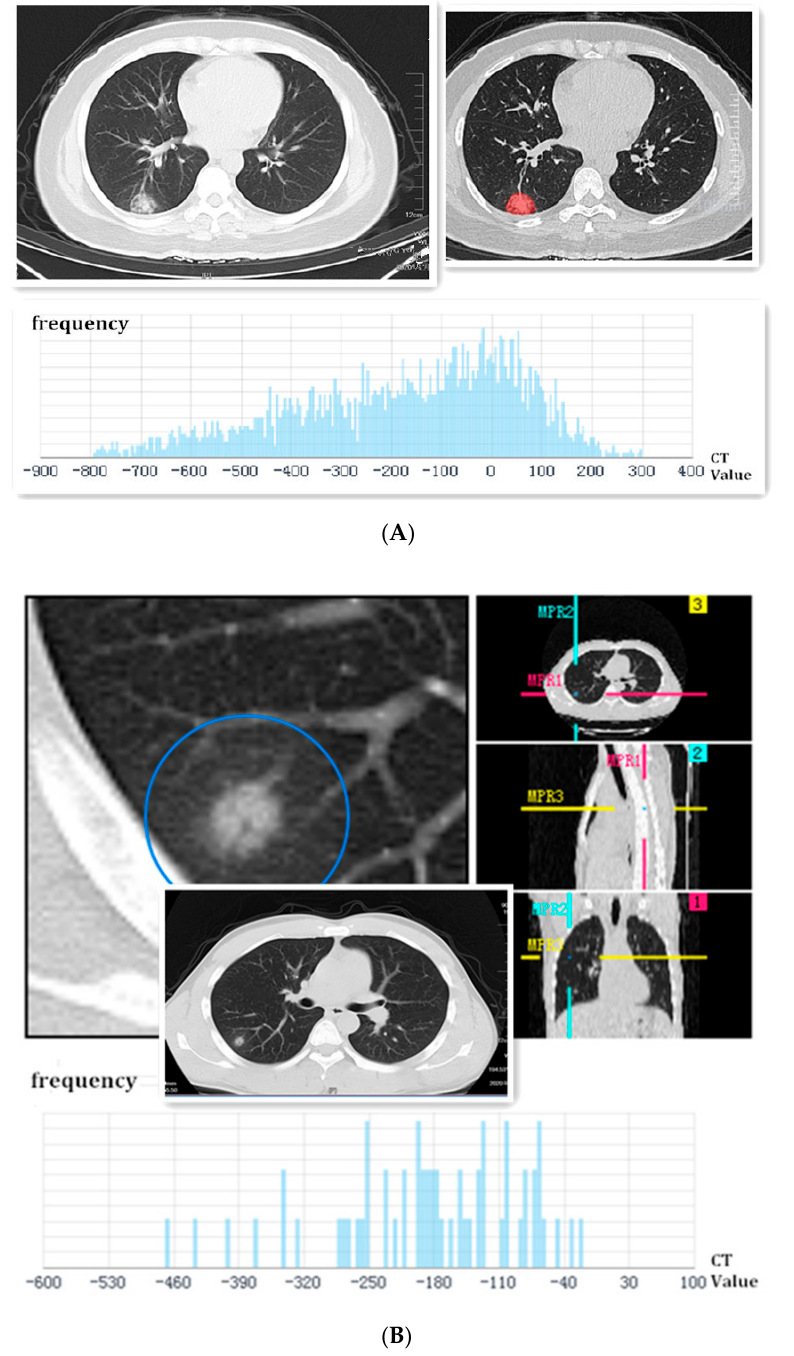
Figure 1. ( A ) Female, 37 years old, a coughing patient without sputum production and fever. The image first displayed a single ground-glass shadow, which had cavities and smooth edges in the peripheral area of the right lower lobe on admission. The SPN was marked by feature extraction of the AI system. Finally, it was identified as a high-risk nodule, and the frequency of CT values was analyzed using AI below the picture. This SPN was confirmed as COVID-19 via throat-swab RT-PCR; ( B ) male, a 33-year-old patient with a low fever. The image first displayed a localized consolidation shadow in the peripheral area of the right lower lobe on admission. The lobulated sign could be seen in the axial section, coronal section, and sagittal section. Finally, it was identified as a high-risk nodule, and the frequency of CT values was analyzed using AI below the picture. This SPN was confirmed to be COVID-19 through throat-swab RT ‒ PCR.